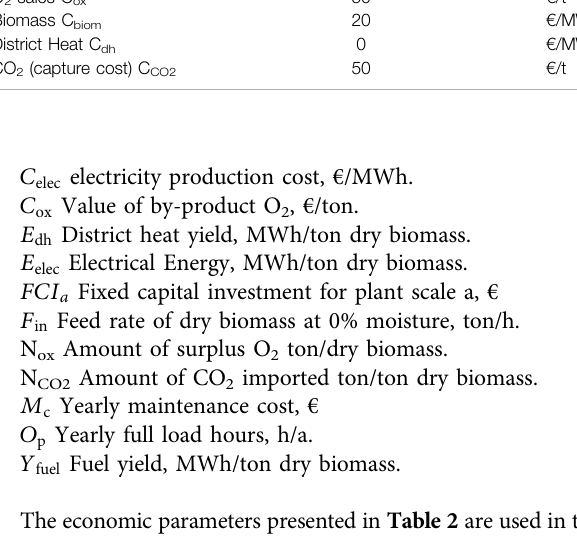
Table A1 in the Appendix. As property method, the Redlich-